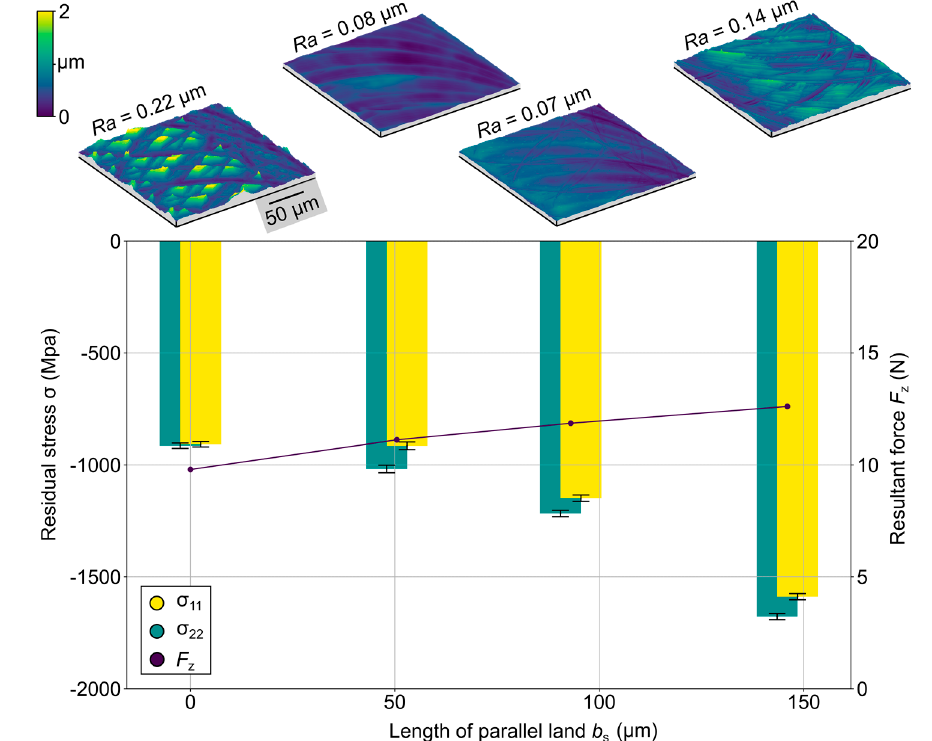
Figure 14. Residual stresses in the subsurface zone of the steel substrate.